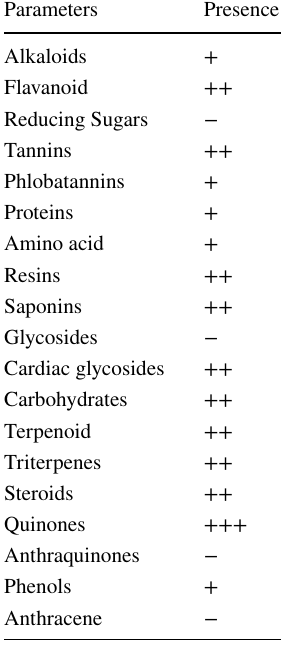
Table 1 Phytochemicals of Gongronema